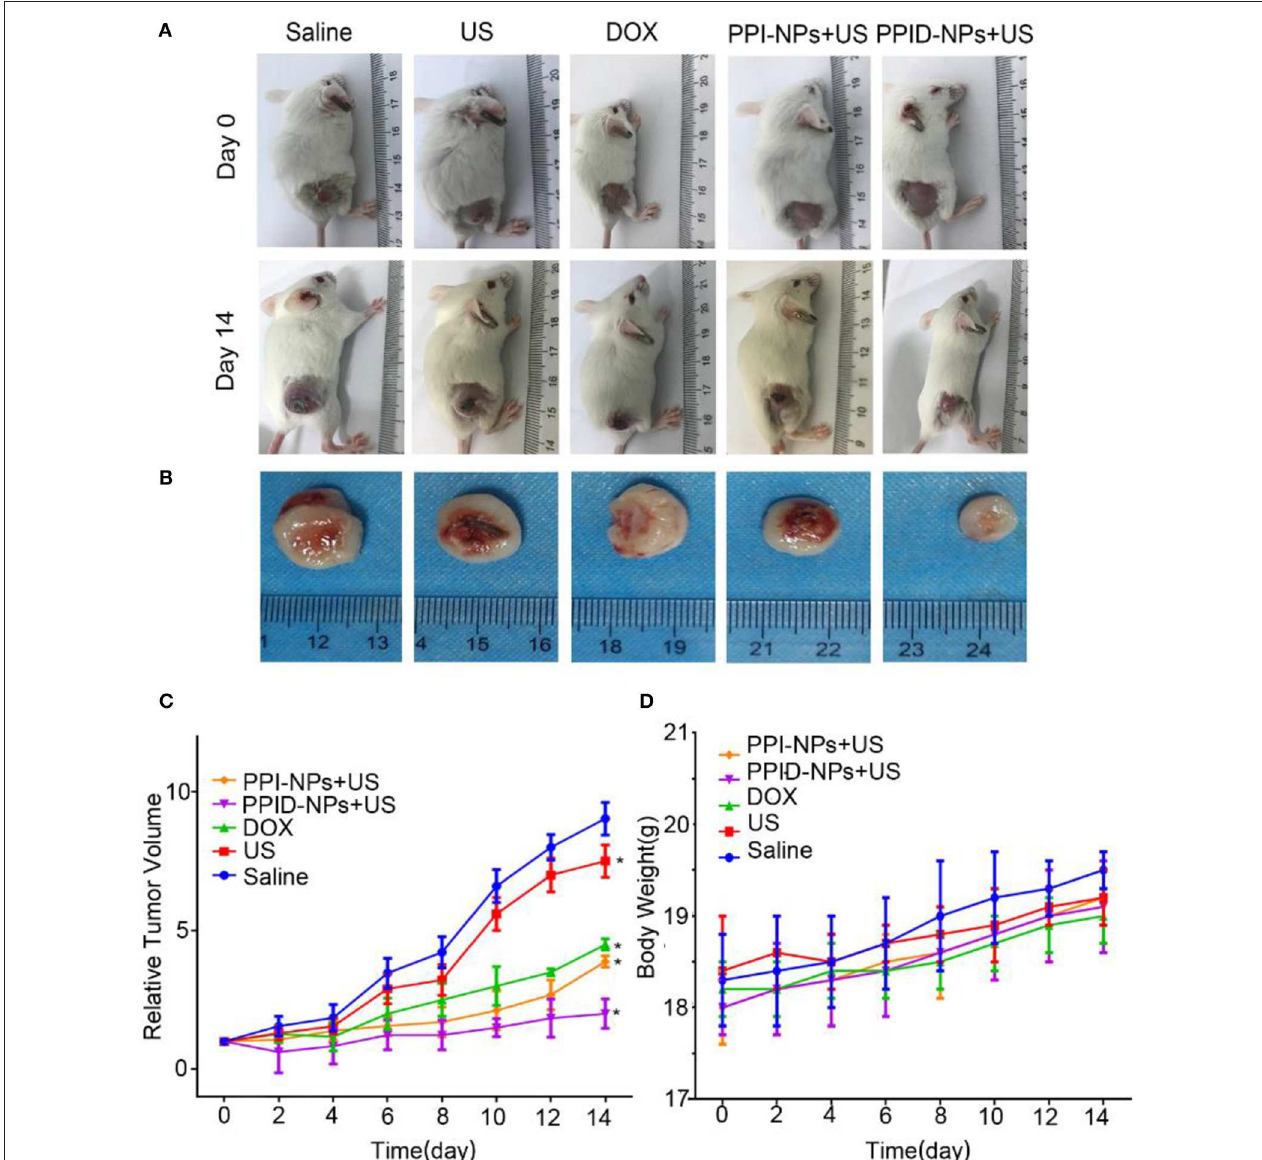
FIGURE 7 | (A) The digital photos of representative mice before and after different treatments. (B) The digital photos of tumor from mice after treatments at day 14. (C) Tumor growth curves of different groups of mice ( n = 5) after various treatments (values are the mean ± SD, n = 5, * p < 0.05, compared with saline, Dunnett’s multiple comparisons test). (D) The weight growth curves of different groups of mice ( n = 5) after various treatments.